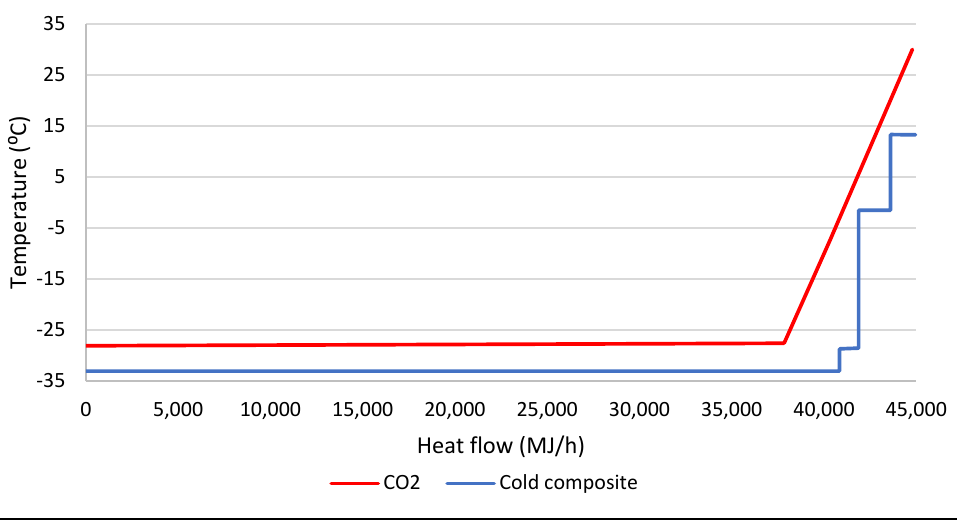
Figure 16. Heat curve of configuration 3. Table 9. Results for the closed-cycle configuration